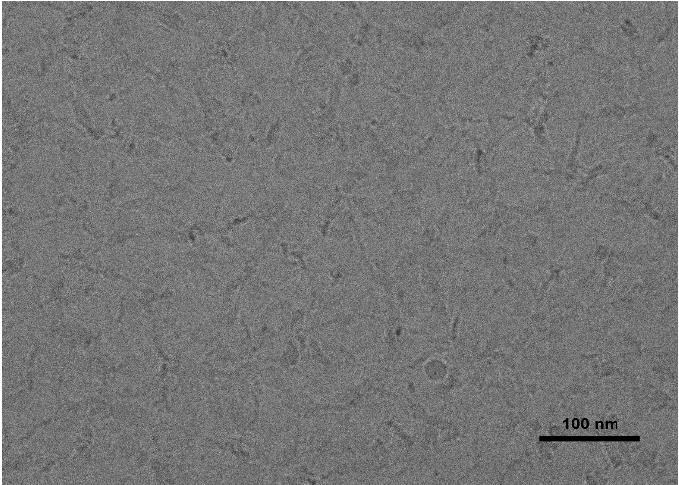
Figure 3. Cryo-TEM image of SA/cyclen (300 mM) in the absence of CO 2 ; The scale bar is 100 nm.